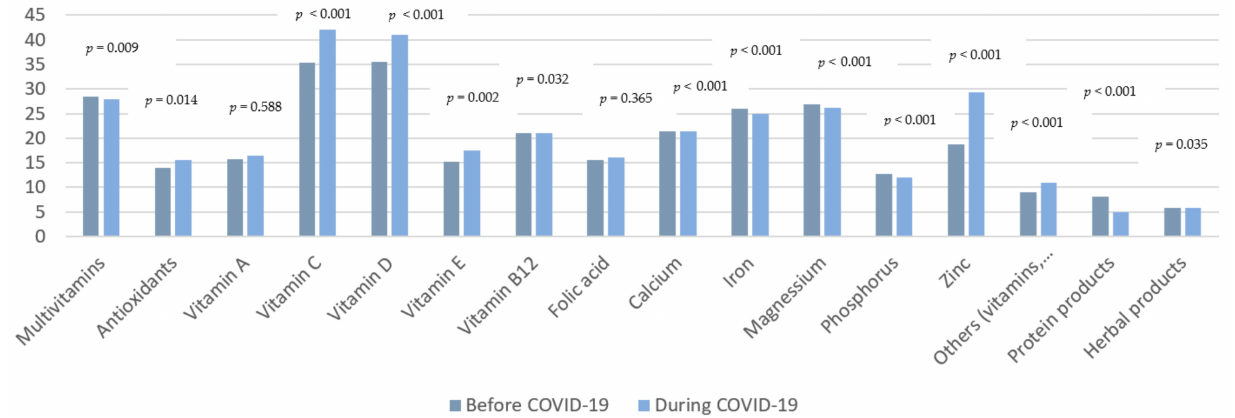
Figure 4. Comparison between the weekly/daily use of DSs before and during COVID-19